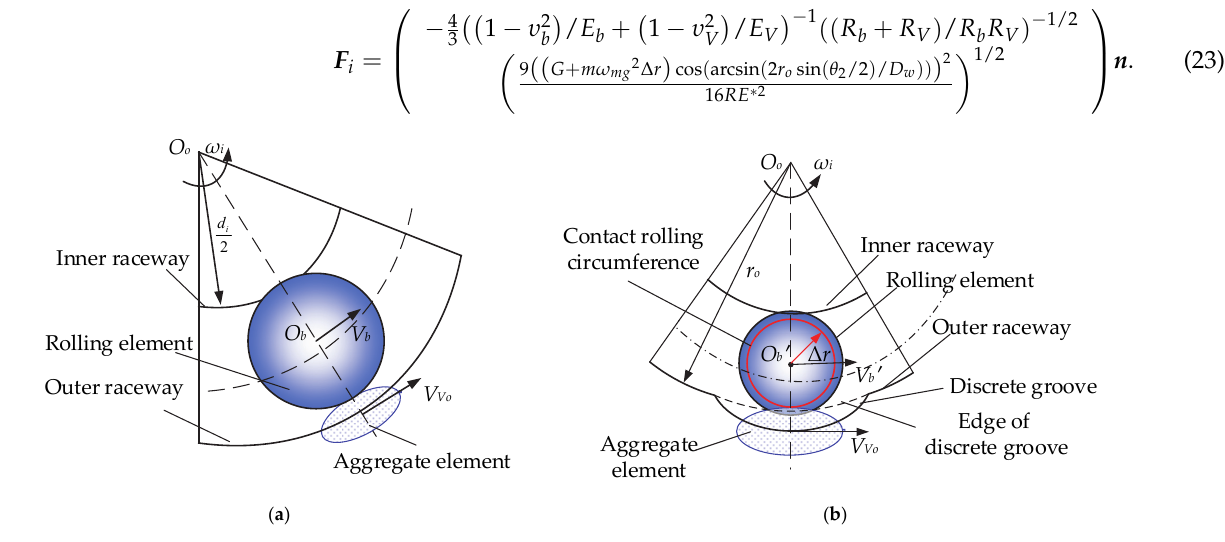
Figure 4. Analysis of the relative velocity of the rolling element to the aggregate element: ( a ) conventional raceway and ( b ) discrete groove. Since the direction of the relative velocity of the rolling element and aggregate ele- ment is perpendicular to the direction of the contact force, the damping force in the contact force equation is 0. Combining Equations (6), (16) and (19), we obtain the contact force between the rolling element and the aggregate element in the bearing region at the con- ventional raceway as